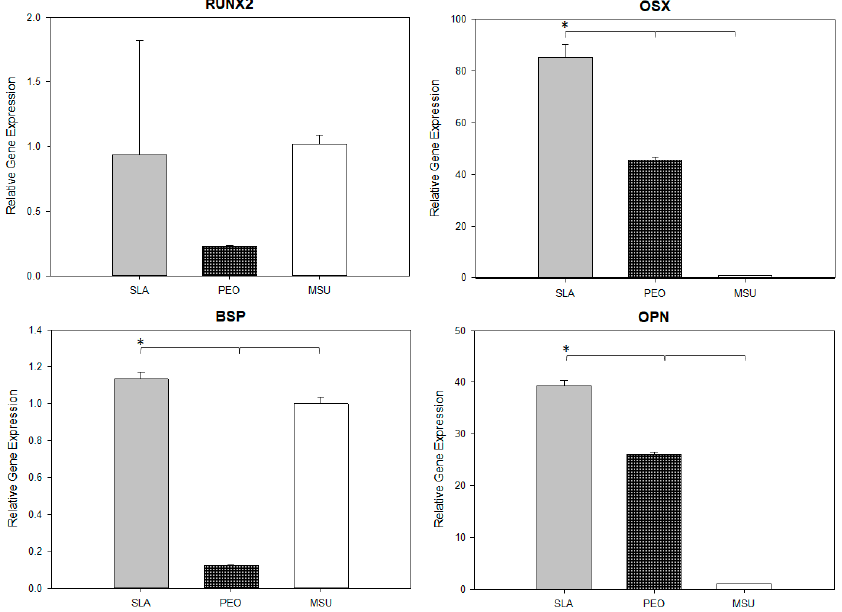
Figure 4. Real-time PCR analysis to determine the expression of RUNX2, OSX, ALP, BSP, OC, and OPN for the SLA surface and PEO-treated surface under cell culture conditions. * represents a significant difference between surfaces ( p < 0.05).